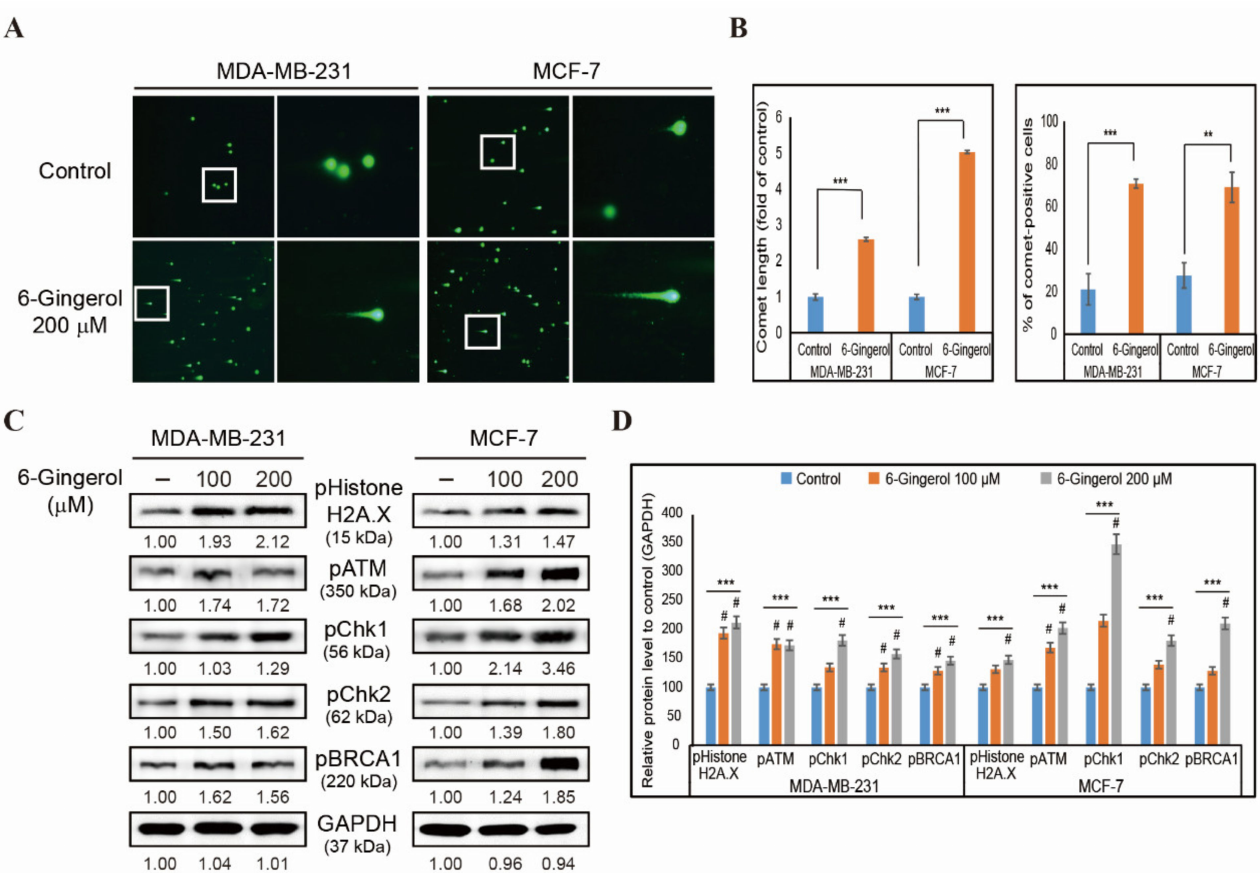
Figure 2. 6-Gingerol induces DDR in breast cancer cells. ( A ) Comet assay images from fluorescent microscopy analysis at 10 × and 40 × magnification showing fragmented DNA migration from the nucleoid body that forms a comet tail in MDA-MB-231 and MCF-7 cells after 48 h treatment with 6-gingerol. ( B ) Graphical representation of comet length was analyzed as the fold change versus the control and % of comet-positive cells with 6-gingerol treatment in breast cancer cells. ** p < 0.01 and *** p < 0.001 (Student’s t -test). ( C ) Western blotting of MDA-MB-231 and MCF-7 cells treated for 48 h with 100 and 200 µ M of 6-gingerol showing the expression of phospho-histone H2A.X, ATM, CHK1, CHK2, and BRCA1. ( D ) Representative expressions of proteins were determined by densitometry and normalized to GAPDH. Controls are set to 100. Data were confirmed after repeating the experiment three times. *** p < 0.001 (ANOVA test). # p < 0.001 vs.